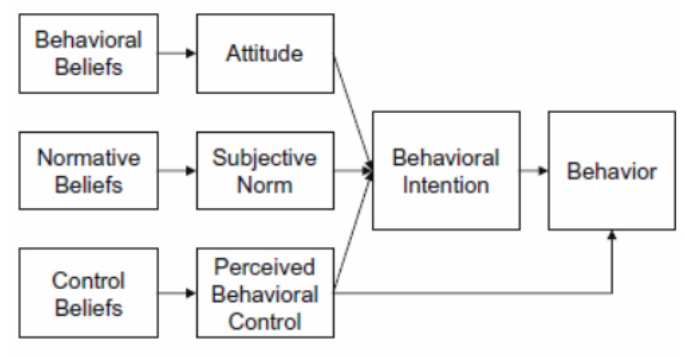
Figure 1. Ajzen’s Theory of Planned Behavior